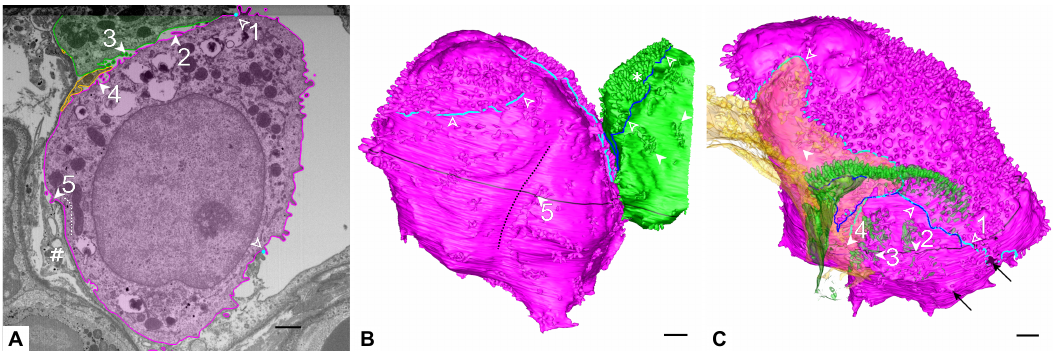
Figure 3. Basolateral surface of AE2 cells. ( A ) Segmented electron micrograph (image 988 of the data set). The micrograph shows the segmentations of the pink and green AE2 cell as well as of the yellow AE1 cell domain with opaque outlines and transparent filling. Microvilli can be found at different sites of the AE2 cell, three of them are indicated on the micrograph: towards the adjacent green AE2 cell, which also shows microvilli at this site (filled arrowheads 2 and 3), towards the yellow AE1 cell domain (filled arrowhead 4), towards an interstitial cell (hash key) through a hole in the basal lamina (filled arrowhead 5). Turquoise circles indicate the lateral luminal cell border of the pink AE2 cell (empty arrowheads). The position at empty arrowhead 1 is found in the 3D model in C. The dotted line indicates the profile of the groove depicted in B. ( B ) 3D Model of the pink and green AE2 cells. The position of the segmented electron microscopic (EM) plane in A is indicated in black and the lateral luminal cell borders of the pink and green AE2 cells are indicated by turquoise and blue delineations, respectively (empty arrowheads; note that the positions do not correspond to the empty arrowheads in A). The pink AE2 cell has only one luminal surface. Note the abrupt appearance of a dense microvilli lawn on the luminal surface in some areas (asterisk). Filled arrowhead 5 indicates the region of the corresponding arrowhead 5 in A. Note also the surrounding basolateral microvilli, which may appear in larger groups. Two sites of basolateral groups of microvilli on the green cell are indicated (unnumbered filled arrowheads). Note the long and mostly smooth groove of the pink AE2 cell surface (dotted line). ( C ) Opaque 3D model of the pink AE2 cell and transparent models of the green AE2 cell and the yellow AE1 cell domain. The position of the segmented EM plane in A is indicated in black. The transparency of the yellow AE1 cell domain and the green AE2 cell enable visualization of intercellular microvilli. Numbered arrowheads correspond to the arrowheads in A: Filled arrowhead 2 and 3: Microvilli between the pink and green AE2 cells. Filled arrowhead 4: AE2 microvilli towards the yellow AE1 cell domain. The unnumbered filled arrowhead indicates another region with AE2 microvilli under the yellow AE1 cell domain. The lateral luminal AE2 cell borders are indicated by turquoise and blue delineations (cf.B). Empty arrowhead 1 refers to the corresponding empty arrowhead in A. Black arrows indicate the small parts of the cell where the cell extends beyond the available dataset. Scale bars: 1 µ